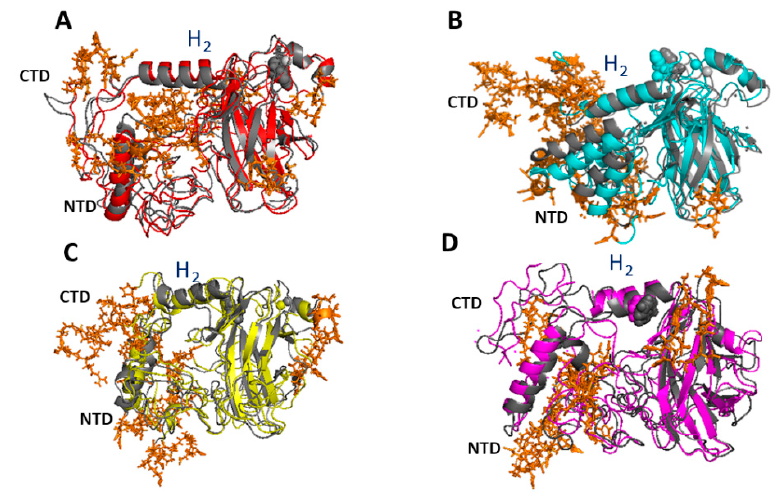
Figure 5. Extreme trajectory conformations projected along the first eigenvector for the four mutated p53 molecule. ( A ) p53R175H; ( B ) p53R248Q; ( C ) p53R273H; and ( D ) p53R282W. Mutated residues and Zn ion are represented as spheres. Regions characterized by displacements between the two extreme projections higher than 0.6 nm are marked by orange sticks.